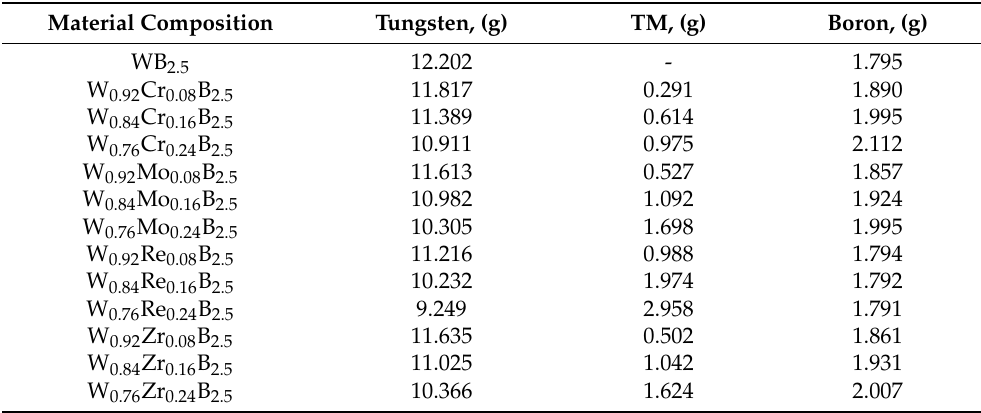
Table 1. Weight content of tungsten, transition metals (chromium, molybdenum, rhenium, zirconium) and boron in W-TM-B powder